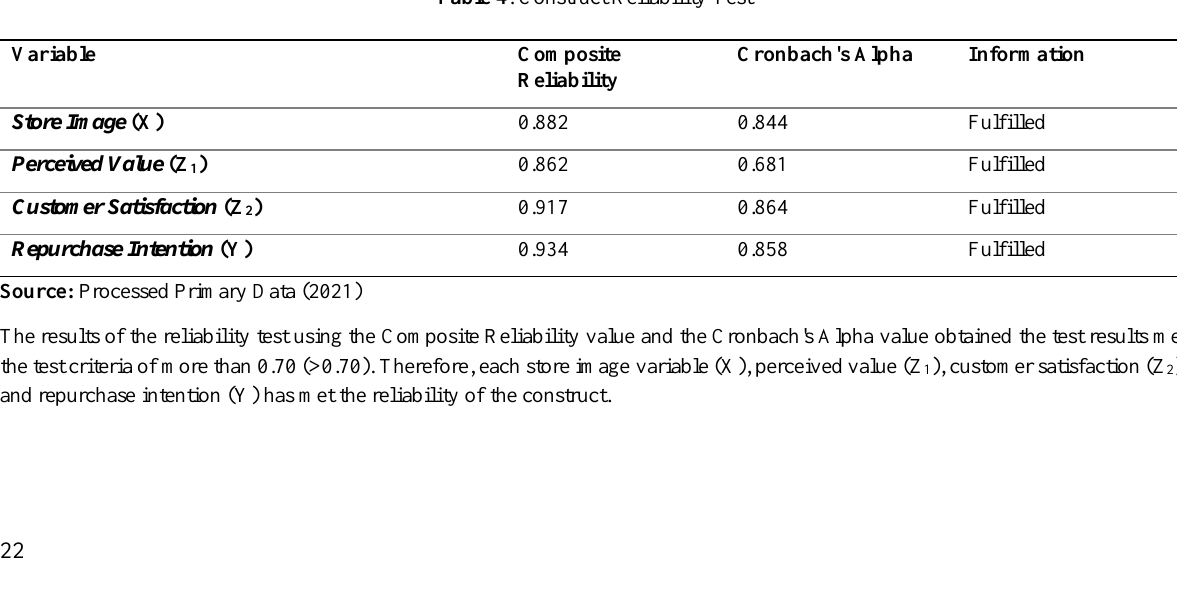
Table 4 . Construct Reliability